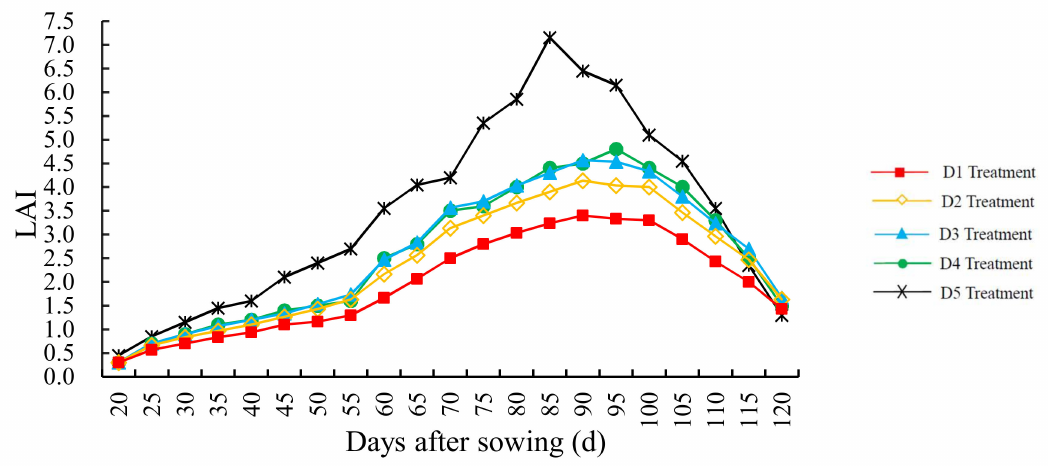
Figure 10. Variation of LAI during the sunflower growth period in